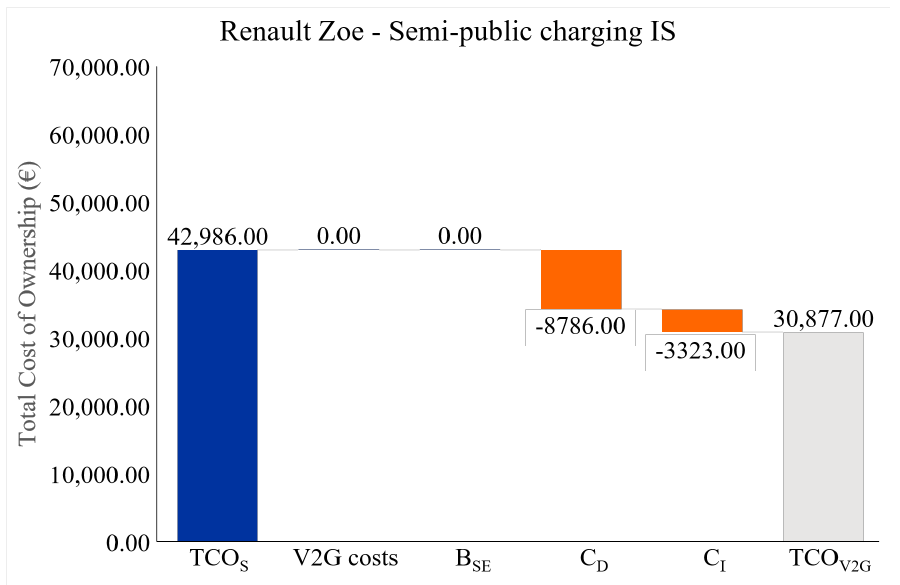
Figure A4. Standard and V2G TCO of a Renault Zoe in a semi-public charging case providing IS ( TCO S = Standard TCO, B SE = benefit of saved electricity costs from the grid, C D = direct compensa- tion, C I = indirect compensation, TCO V 2 G = V2G TCO); source: own compilation).